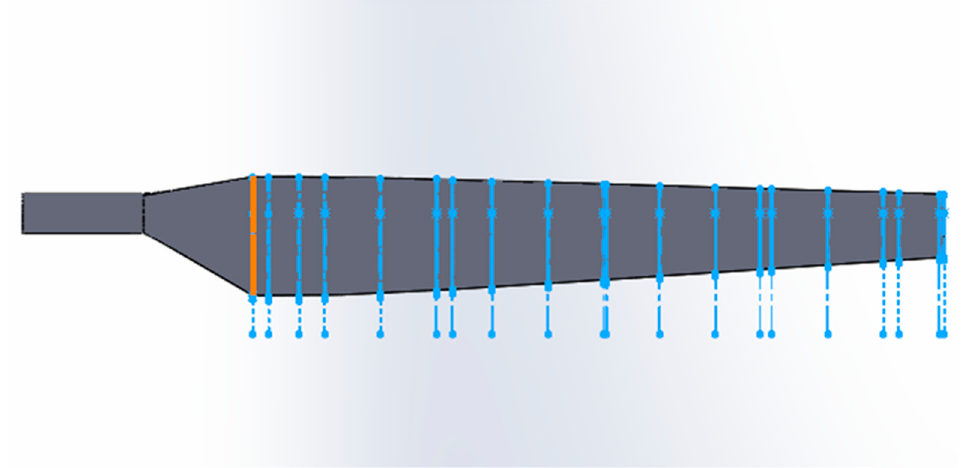
Figure 5. Blade geometry and location of 20 sections.